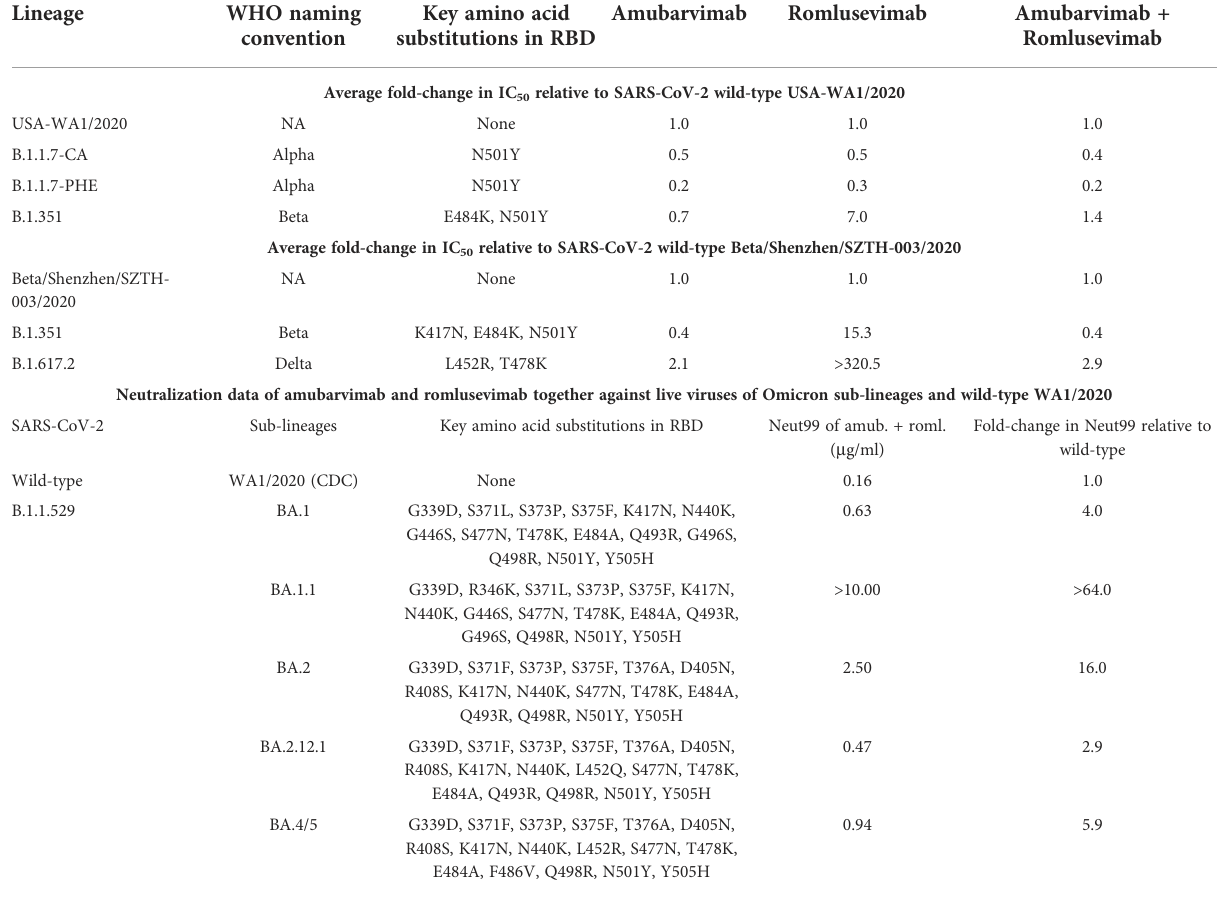
TABLE 3 Amubarvimab and romlusevimab effectively neutralize most live viruses tested.